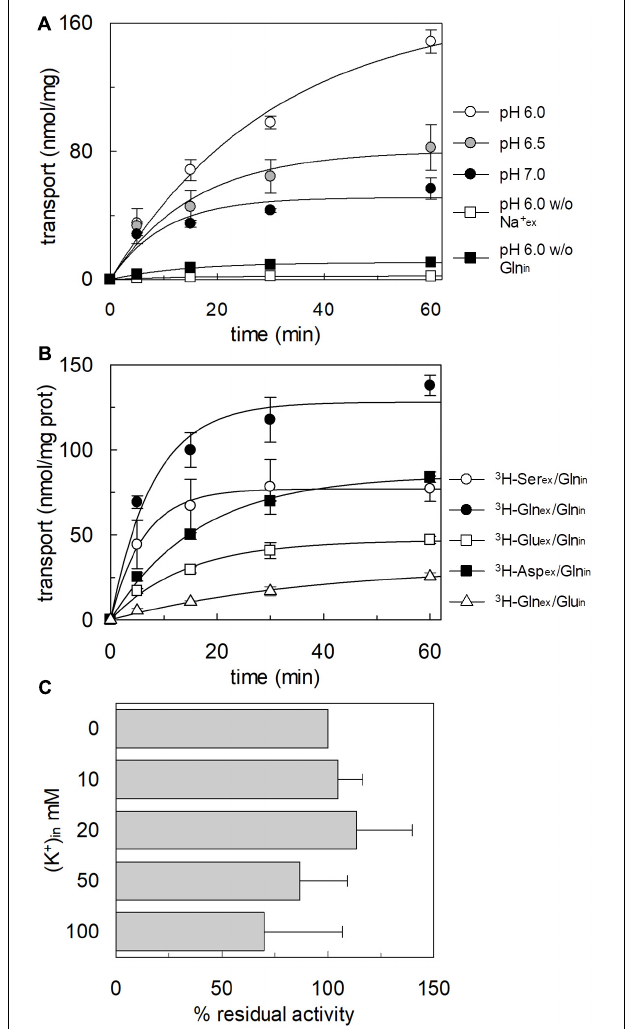
FIGURE 3 | Functional characterization of glutamate transport by hASCT2 reconstituted in proteoliposomes. Purified hASCT2 was reconstituted